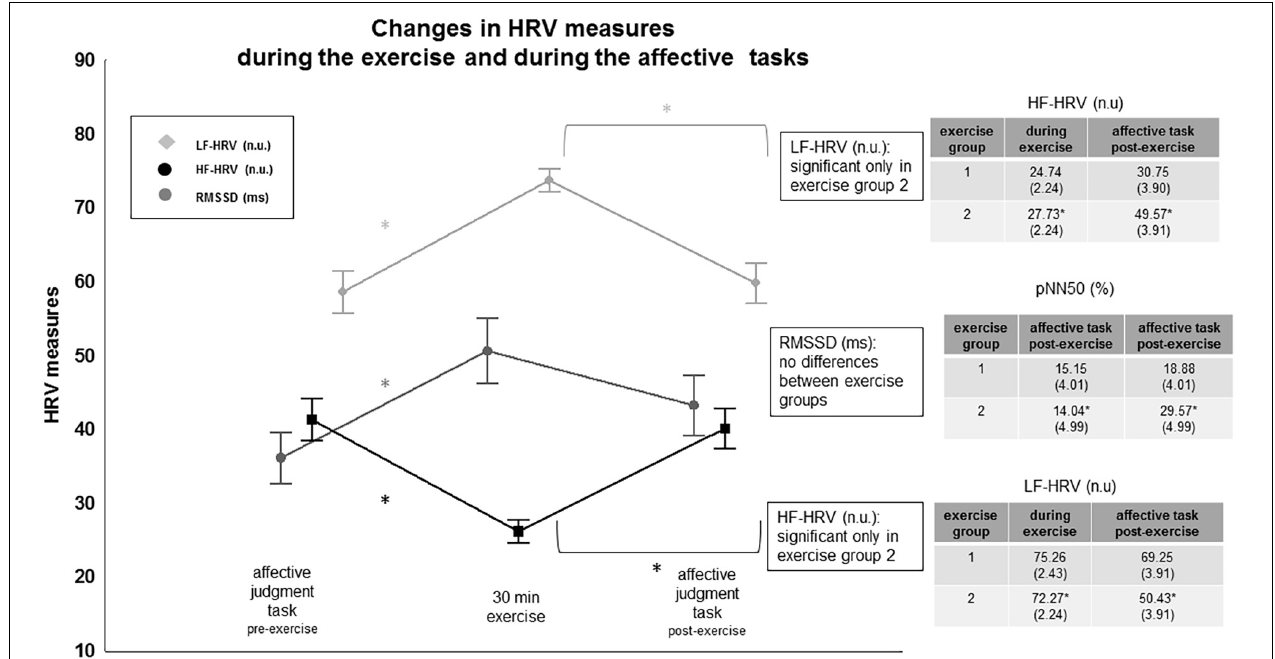
FIGURE 4 | Changes in HRV frequency-domain and HRV time-domain measures. “*” indicates significance. For details, see